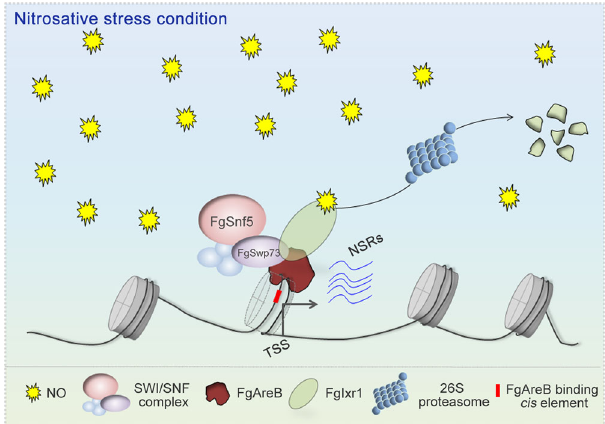
Fig. 7 A proposed model for transcriptional regulation mechanism in response to nitrosative stress in F. graminearum . Nitrosative stress leads to degradation of transcription repressor FgIxr1 by the 26S proteasome. The degradation of FgIxr1 promotes the recruitment of the SWI/SNF complex by the pioneer transcription factor FgAreB, subsequently activates the expression of NS response genes and eventually accelerates NO metabolism. NO (Nitric Oxide), NSRs (Nitrosative Stress Response genes); TSS (Transcription Start